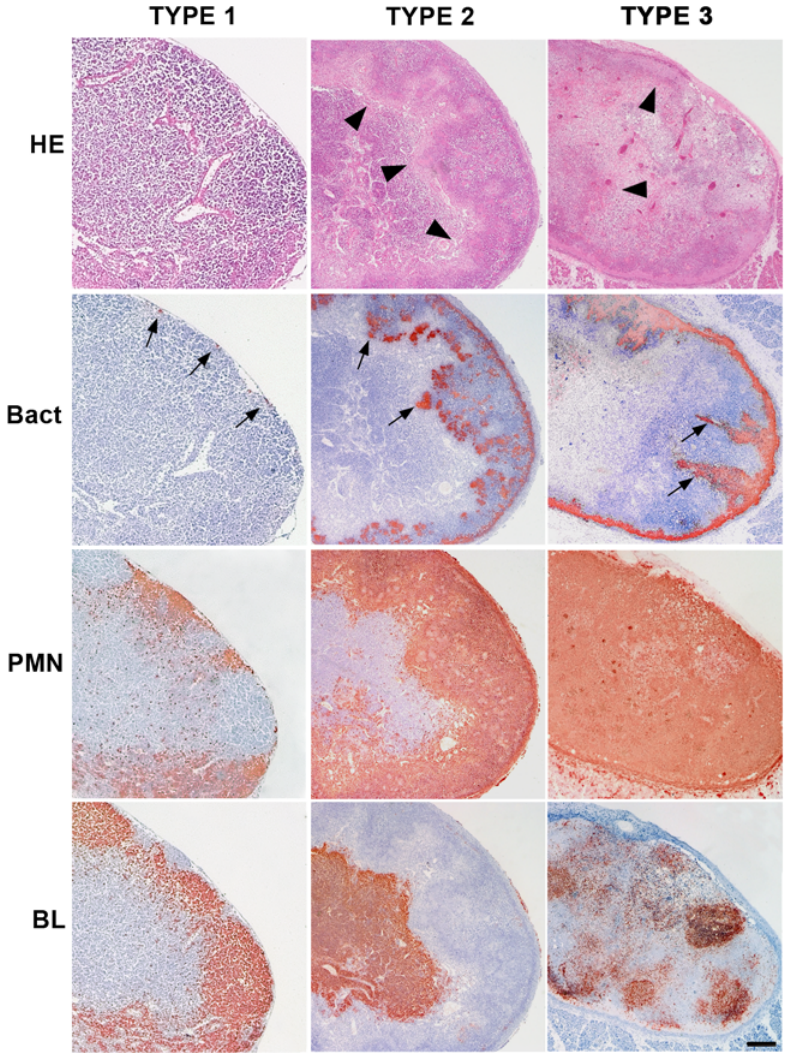
Figure 6. Examples of the three histopathological types of the draining lymph nodes. Lymph nodes were taken 24 h (type 1) and 72 h (type 2 and 3) after inoculation of , 4500 cfu of Y. pseudotuberculosis (types 1 and 2) or Y. pestis (type 3). Sections were stained by Hematoxylin-Eosin (HE), and by antibodies specific to Y. pseudotuberculosis or to Y. pestis (Bact), to PMNs and to B lymphocytes (BL). Immunostainings give a brownish color. Arrowheads on the HE-stained sections indicate the border of the inflammatory front. Bacteria (arrows) are present as tiny bacterial foci at the periphery (type 1), well delimited patches (type 2) or flame-like formations (type 3). The BL staining shows that the overall structure of the type 1, but not of the type 3, lymph node is preserved, while, in the type 2 lymph node, the inflammatory reaction forced B lymphocytes to the central part of the organ. Bar=100 m m.